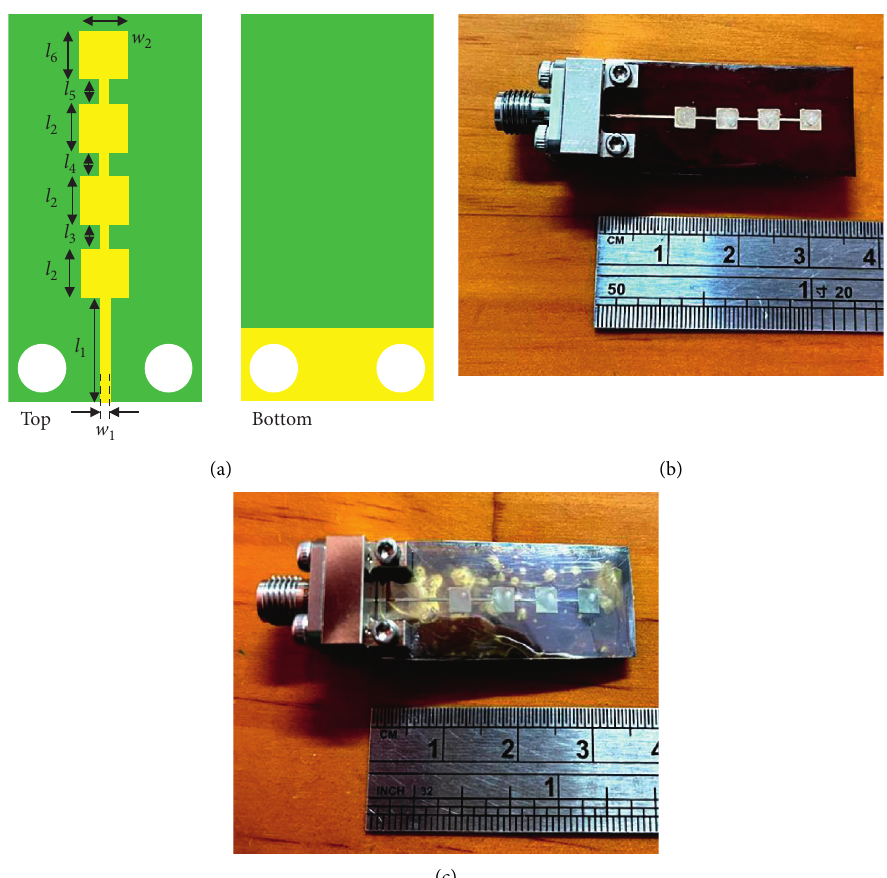
Figure 13: (a) The geometry of the fully inkjet-printed 4 × 1 flexible subarray and the photographs of the antenna fabricated on (b) PI and (c) PEN.